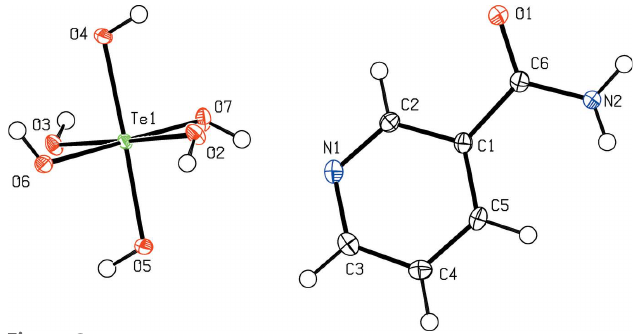
Figure 2 The title molecule with anisotropic atomic displacements shown at the 50% probability level ( PLATON ; Spek,